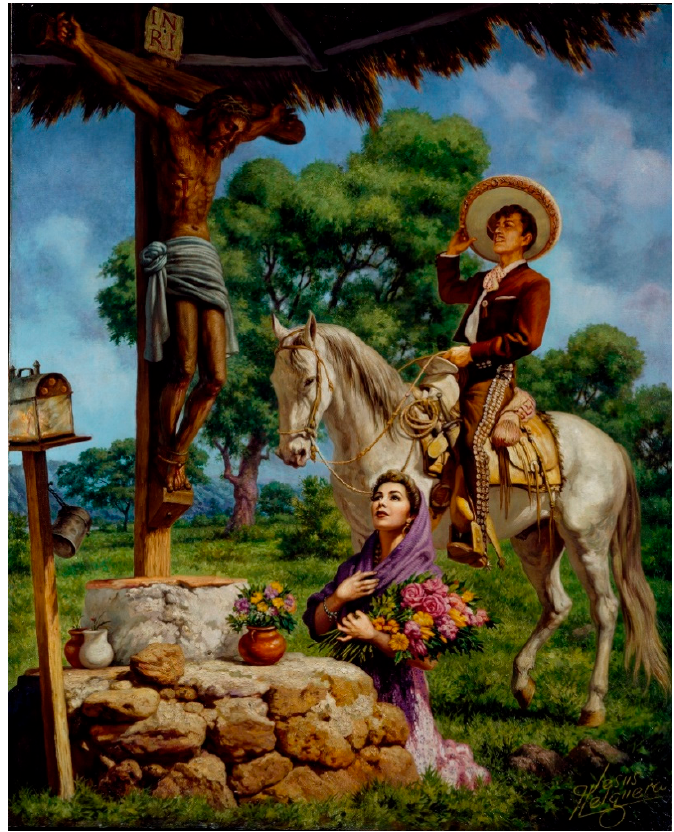
Figure 1. Source: Jesús de la Helguera. “La cruz del camino” Reproduced with permission. Soumaya Museum.